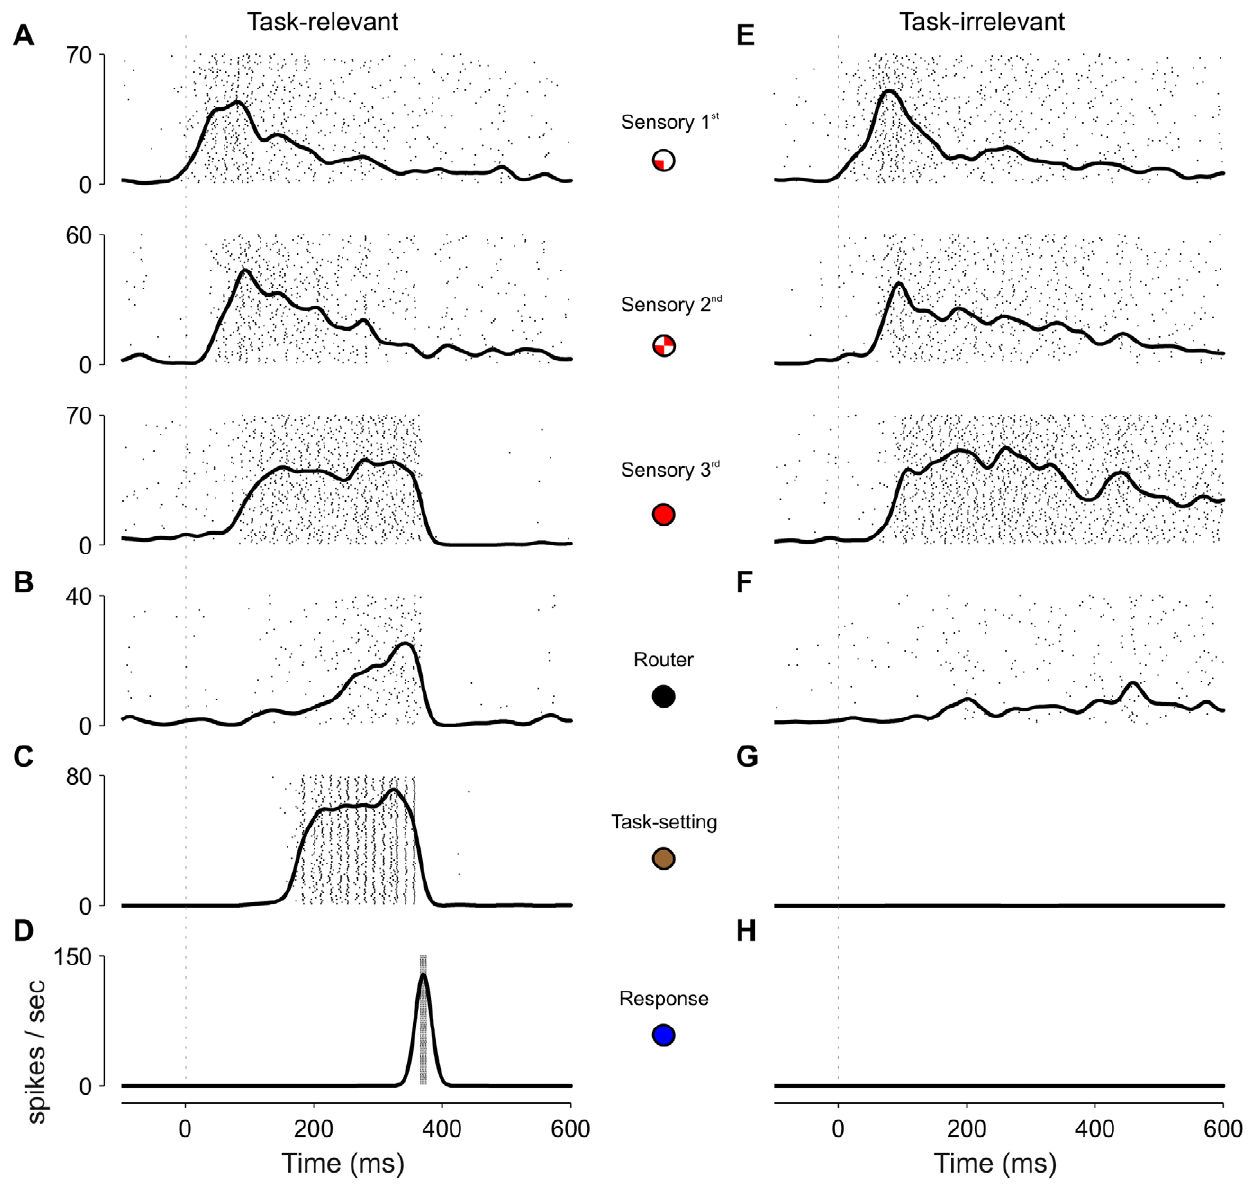
Figure 2. Single-trial dynamics for task relevant and irrelevant stimuli. Firing rates of representative trials of task-relevant (A–D) and task- irrelevant (E–H) stimuli. Each panel shows the firing rates averaged across a population (thick line) overlapped with spike rasters (each row of dots represent the spiking activity of a neuron in the population). Average firing rates were calculated by convolving the spike raster from a single trial with a gaussian filter of s =12 ms . (A) Stimulus presentation (indicated with a dashed vertical line) generates a wave of activity that propagates through the successive stages of the sensory hierarchy. The colored circles represent the features coded by the various populations, following the notation of figure 1. (B) Router neurons show ramping activity until a response threshold is reached. (C) Activity in task-setting neurons is triggered by excitatory input from sensory neurons and is sustained for the duration of the task. (D) The response is signaled by a burst of excitatory neurons in the response network. (E–H) Same as panels A–D, but with the connections from sensory to task-setting areas removed. In the absence of projection from task-setting neurons (G) the activity in the router (F) does not reach the threshold to trigger a response in motor areas (H), despite strong activation in sensory areas